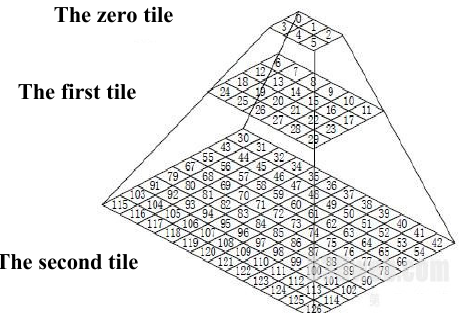
Figure 1. The traditional process method of remote sensing